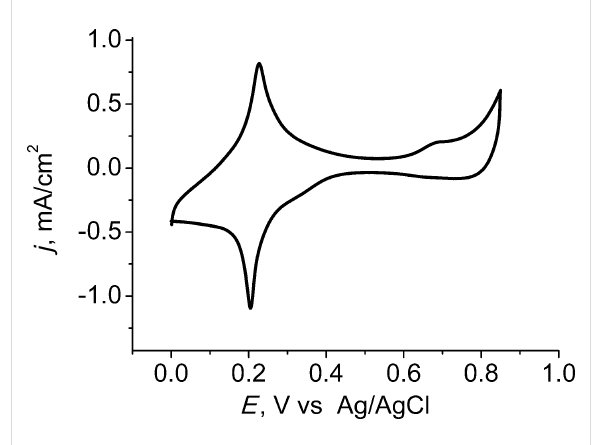
Figure 2: Cyclic voltammogram of three PB-Ni-HCF bilayers deposited on a platinum ultramictroelectrode (0.1 M KCl and 0.1 M HCl, sweep rate 20 mV·s − 1